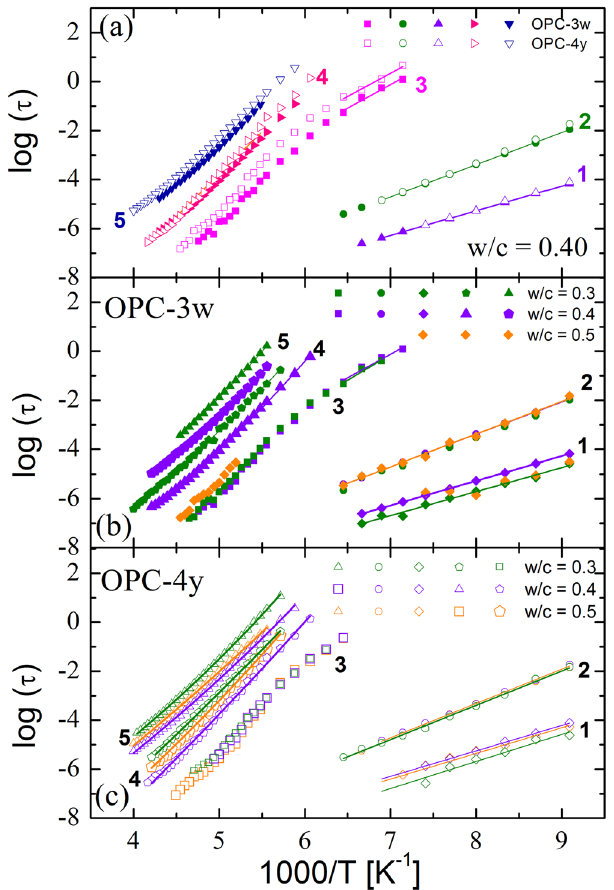
Figure 4. ( a ) Temperature dependence of relaxation times of water confined in OPC w / c = 0.4 after 3 weeks and 4 years of preparation. ( b and c ) Temperature dependence of relaxation times of water confined in cements with different w / c ratios after 3 weeks ( b ) and 4 years ( c ) of